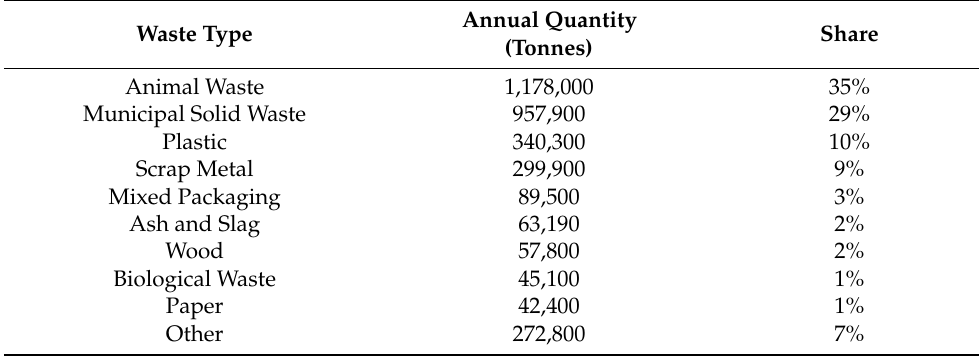
Table 3. Greek participants waste stream quantities.